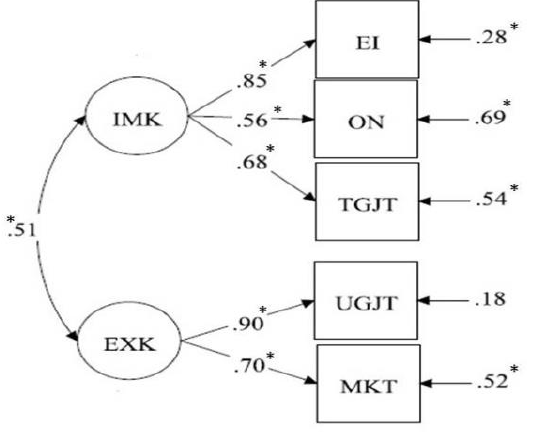
CFA Model 1 based on data from Ellis & Loewen